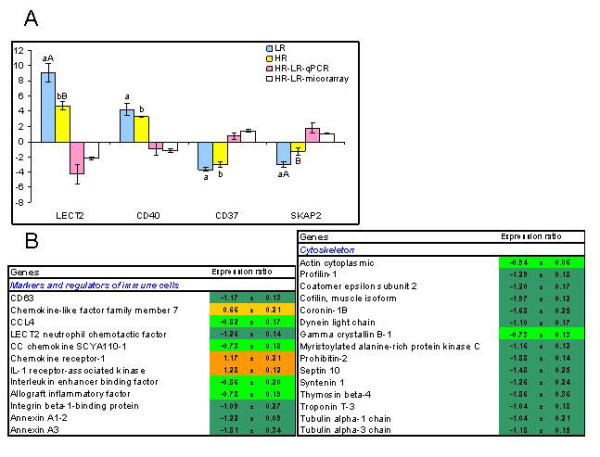
Immune cell markers and genes involved in recruitment and migration of immune cells. A: Real-time qPCR versus microarray analyses. Results demonstrated concordance in direction of change between the two techniques supporting differential regulation of the gene subset. Data for qPCR are ΔΔCt ± SE of 10 HR and 10 LR versus 8 fish in the unchallenged control and data for microarray are mean log2-ER ± SE of 6 HR fish hybridized to a pooled sample of 10 LR fish. Differences between HR and LR determined with microarrays and qPCR are shown. Different capital letters (A, B) denote a difference between challenged fish (HR and LR) while small letters (a, b) denote a difference between challenged and control fish (ANOVA, P < 0.05). LECT2 - leukocyte cell-derived chemotaxin 2, SKAP2 - Src kinase-associated phosphoprotein. B: Microarray results, examples of differentially expressed genes with significant differences between vaccinated and unvaccinated fish (t-test, n = 6 and 5, p < 0.05). Results for unvaccinated fish are not shown, data are log2-ER ± SE.